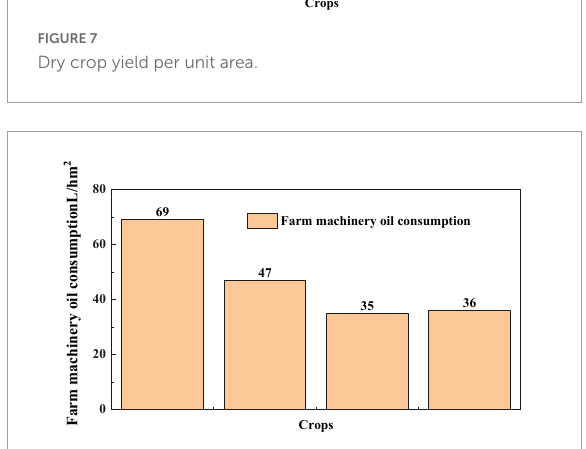
FIGURE7 Dry crop yield per unit area.